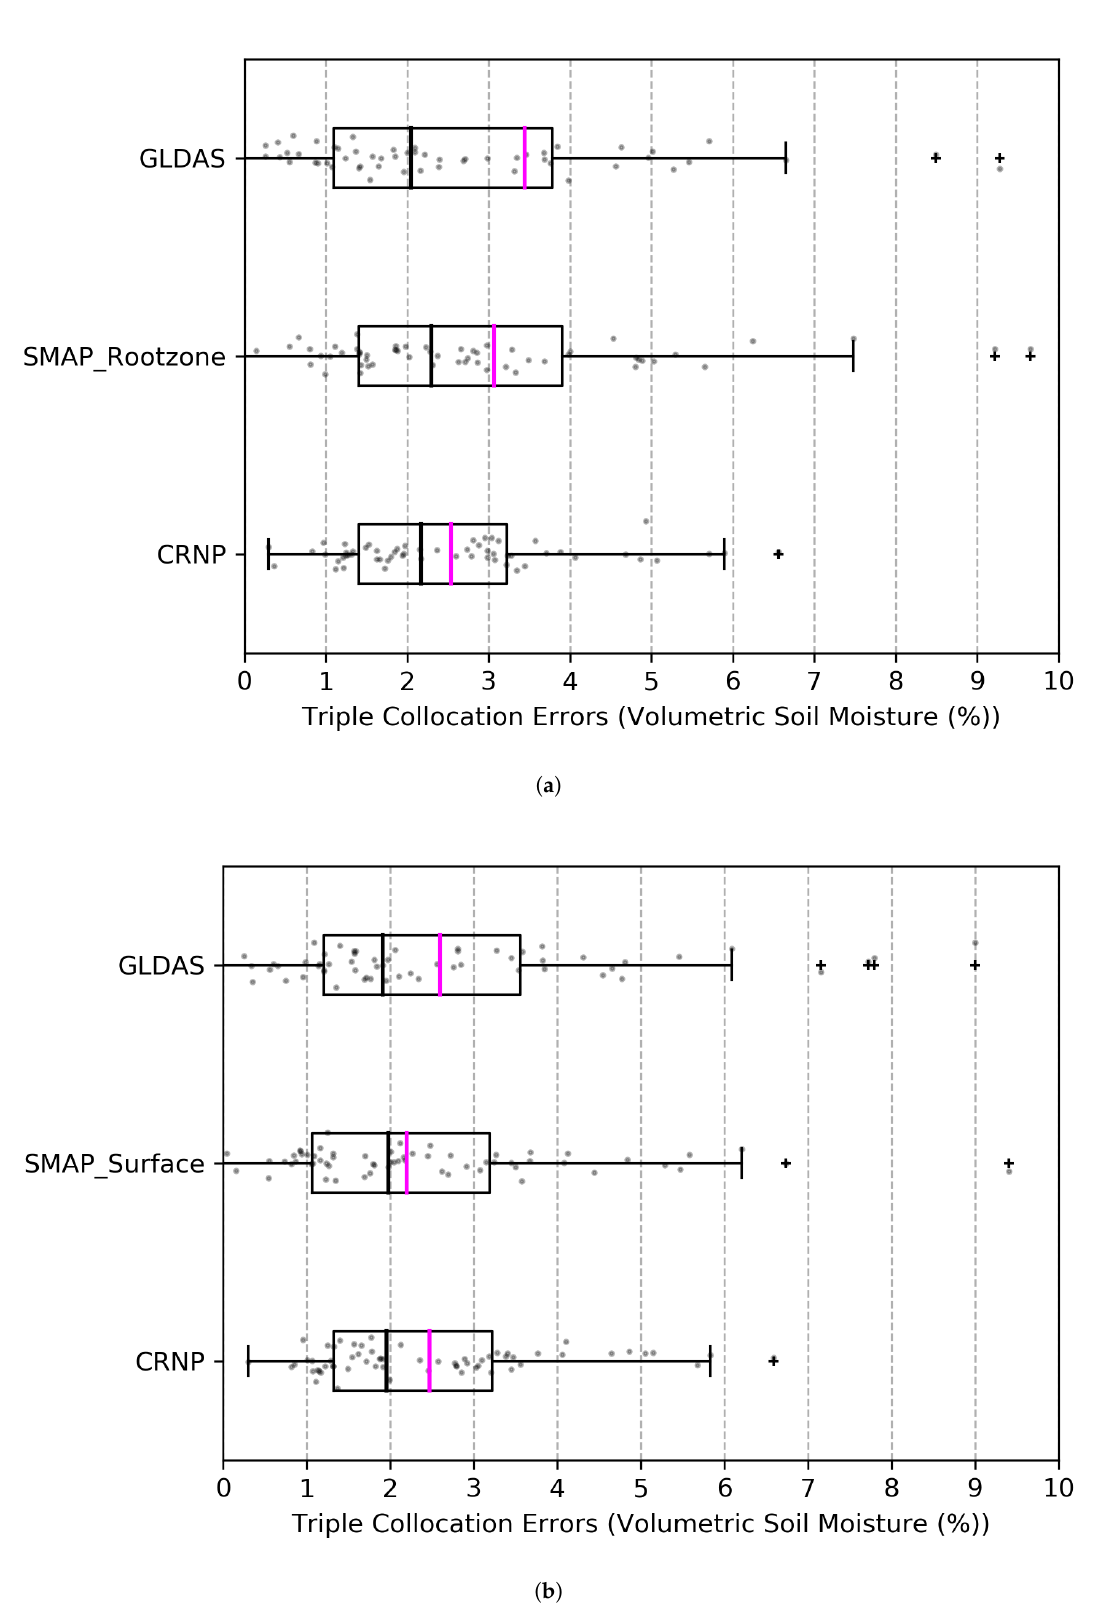
Figure 8. Triple collocation errors of soil moisture products for observed (CRNP), modelled (GLDAS) and satellite (SMAP) for COSMOS database, pink lines show the mean values and + signs depict outliers. ( a ) Triple collocation errors of GLDAS–SMAP Rootzone–CRNP. ( b ) Triple collocation errors of GLDAS-SMAP